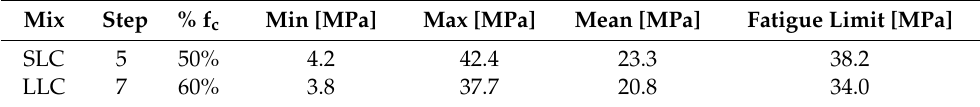
Table 6. Fatigue failure step for LLC and SLC mixes: frequency reduction criterion.